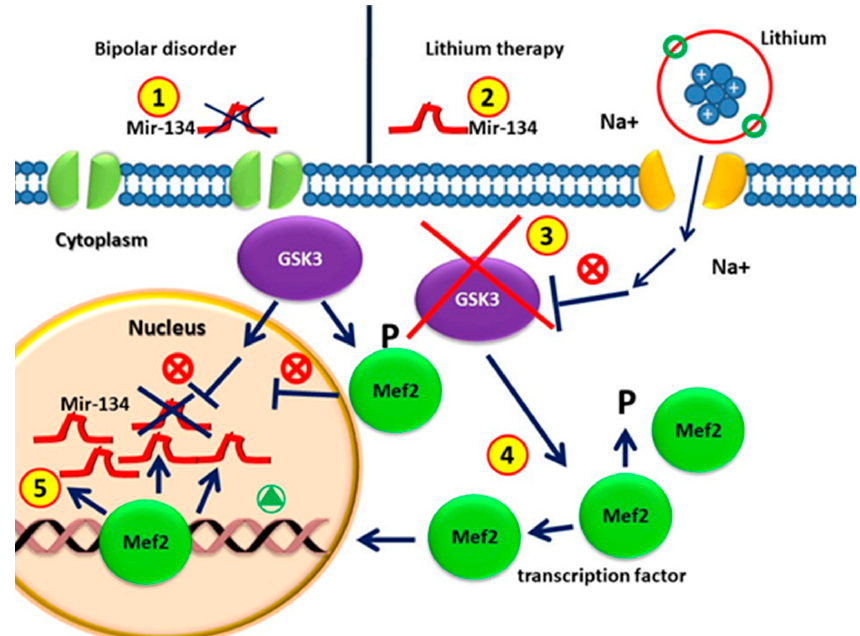
Figure 2. (1) Circulating MiR-134 in patients with bipolar disorders without drugs is lower than that in healthy individuals; (2) MiRNA-134 levels increase significantly after four weeks of lithium treat- ment; (3) GSK3 β is the therapeutic target of lithium in the treatment of BD. (4) GSK3 β is involved